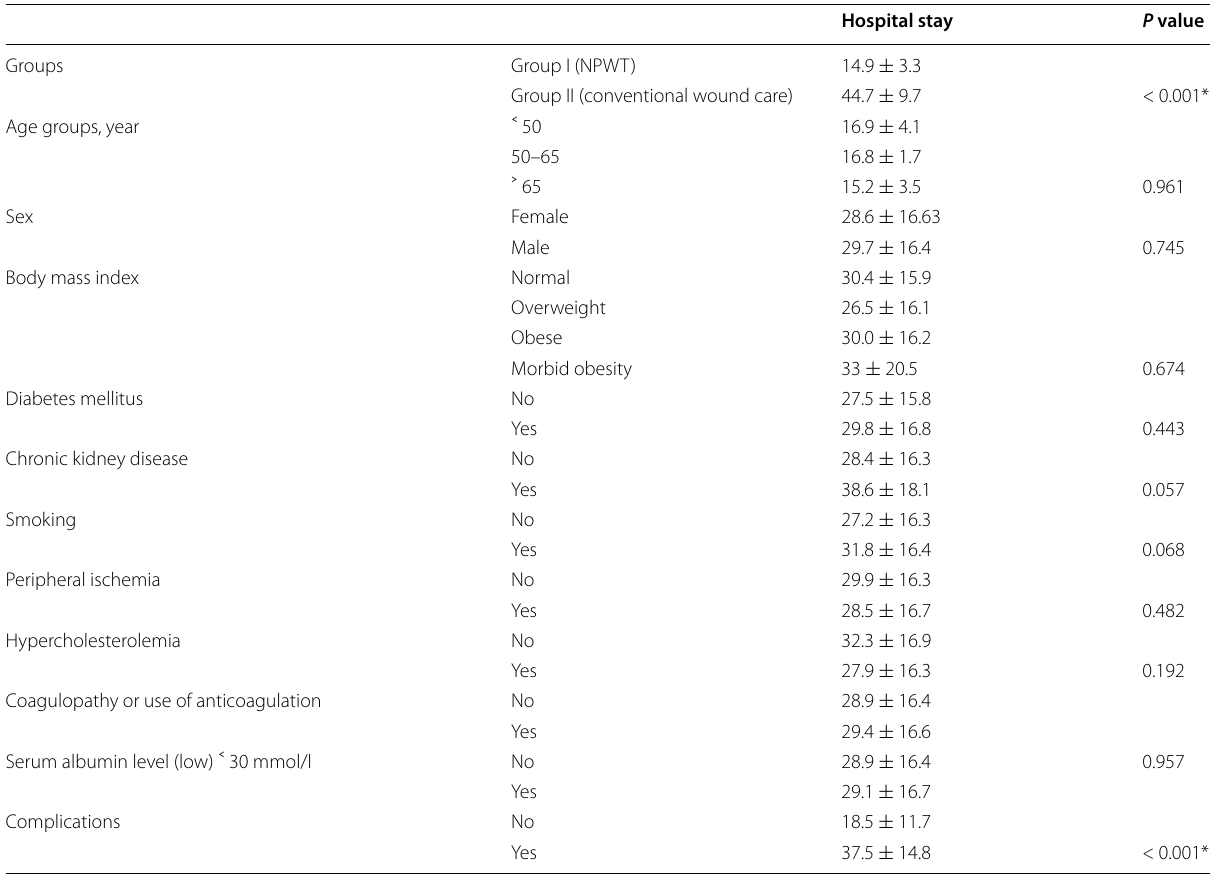
Table 5 Univariable analysis for factors affecting hospital stay length